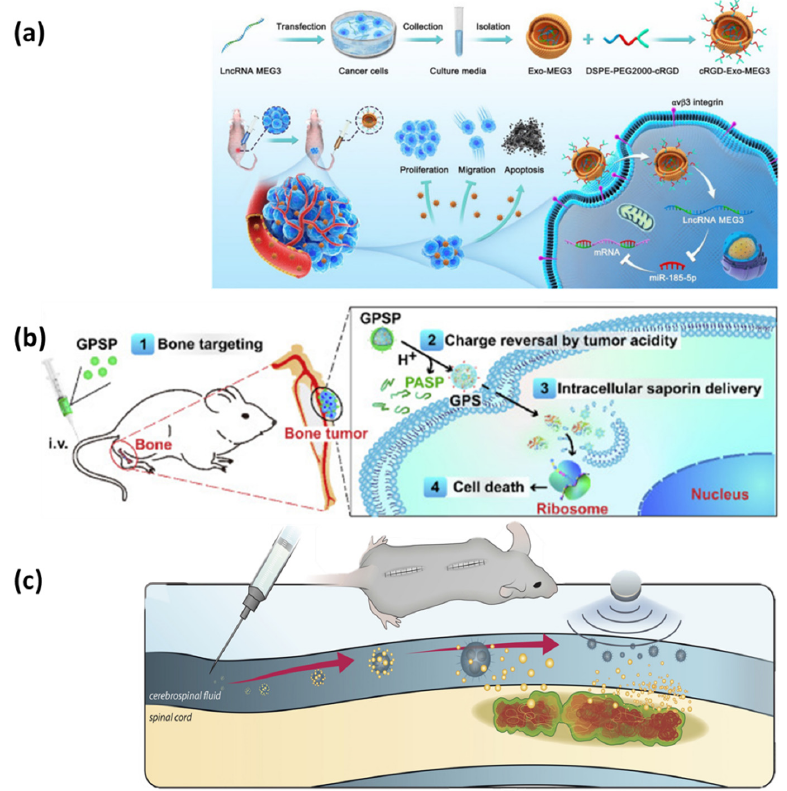
Figure 2. ( a ) Schematic representation of fabrication and working principle of the experimental design employed by Huang et al. Reprinted with permission from [66], © Elsevier, 2022. ( b ) Schematic representation of the working principle of the experimental design employed by Yan et al. Adapted from an open-access source [61]. ( c ) Schematic representation of the working principle of the experimental design employed by Kheirkhah et al. Adapted from an open-access source [70]. To summarize the above-discussed studies, Table 1 correlates the nanocarrier, transported chemotherapeutic, mechanisms of action, and targeted tumor type. Table 1. Summary of discussed tumor-targeting therapies.